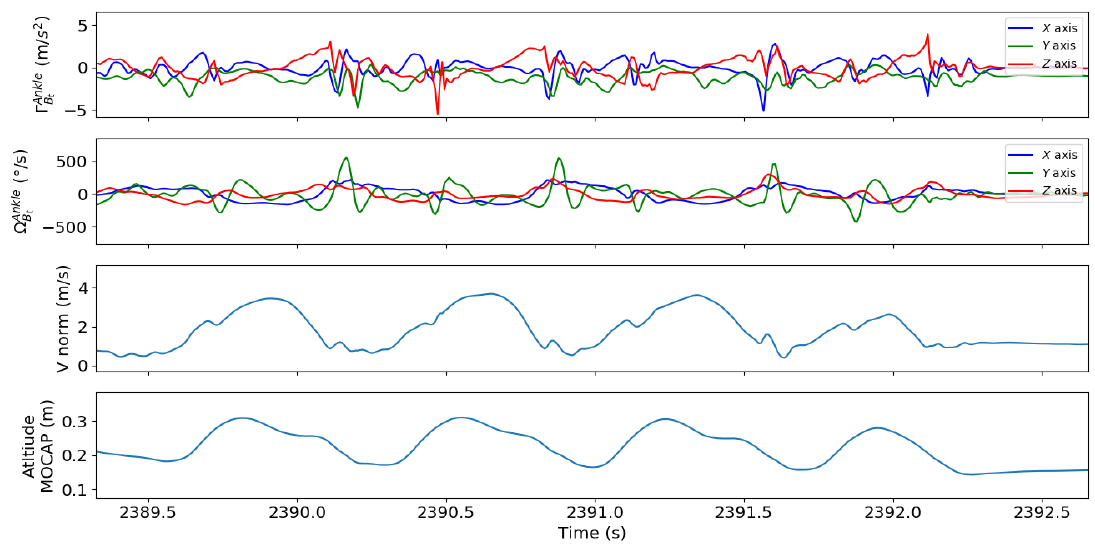
Figure A2. Pseudo-speed norm during fast side